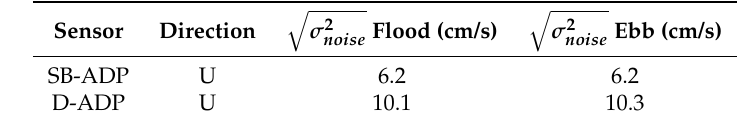
Table 4. Correction factors reported as the standard deviation in cm/s due to sensor noise for turbine-mounted SB-ADP and seabed-mounted D-ADP data in the absence of waves. Sensor Direction